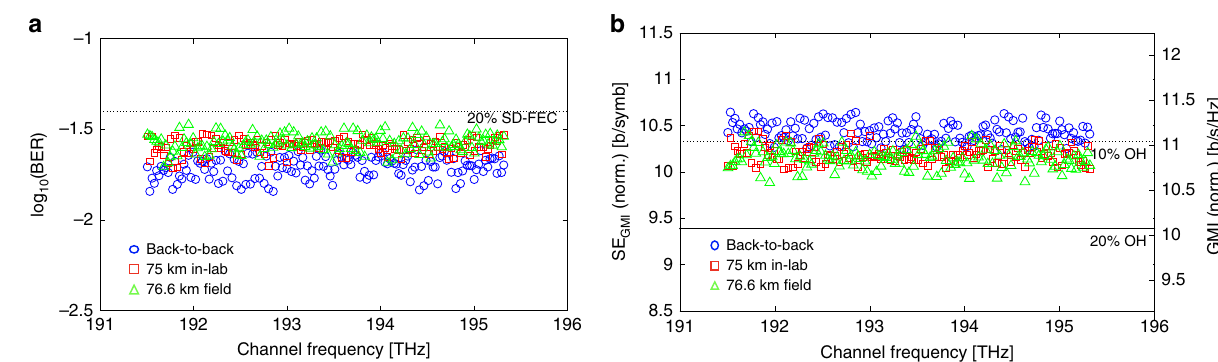
Fig. 4 Bit-error ratio, spectral ef fi ciency and GMI for transmission experiment. a BER for each comb line. Blue circle points indicate the performance of